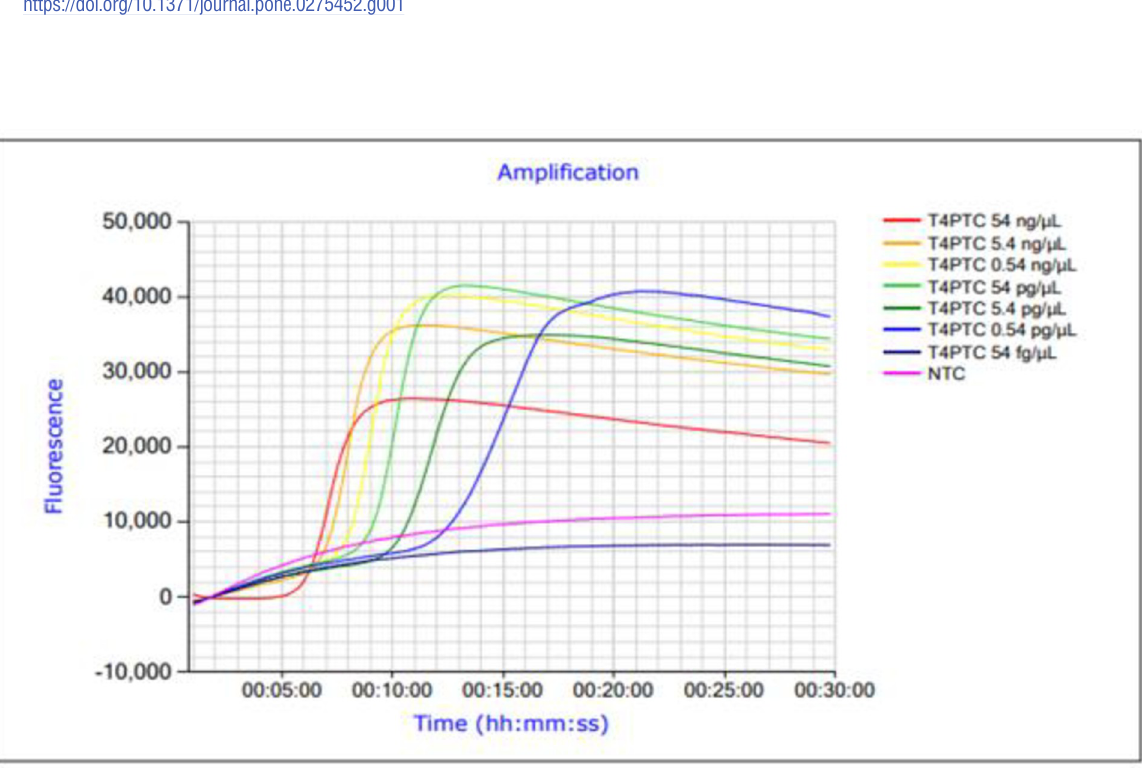
Fig 2. Amplification profile of the Thunnus albacares LAMP assay using different dilutions. The samples contained DNA concentrations of 54ng/ μ L to 54 fg/ μ L. NTC = non-template control.